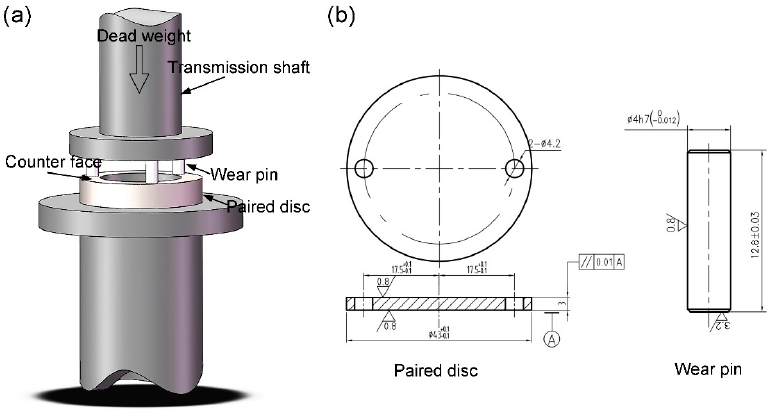
Figure 2. Schematic representation of experimental setup: ( a ) pin-on-disc configuration, ( b ) surface topography parameters of disc and pin surfaces.